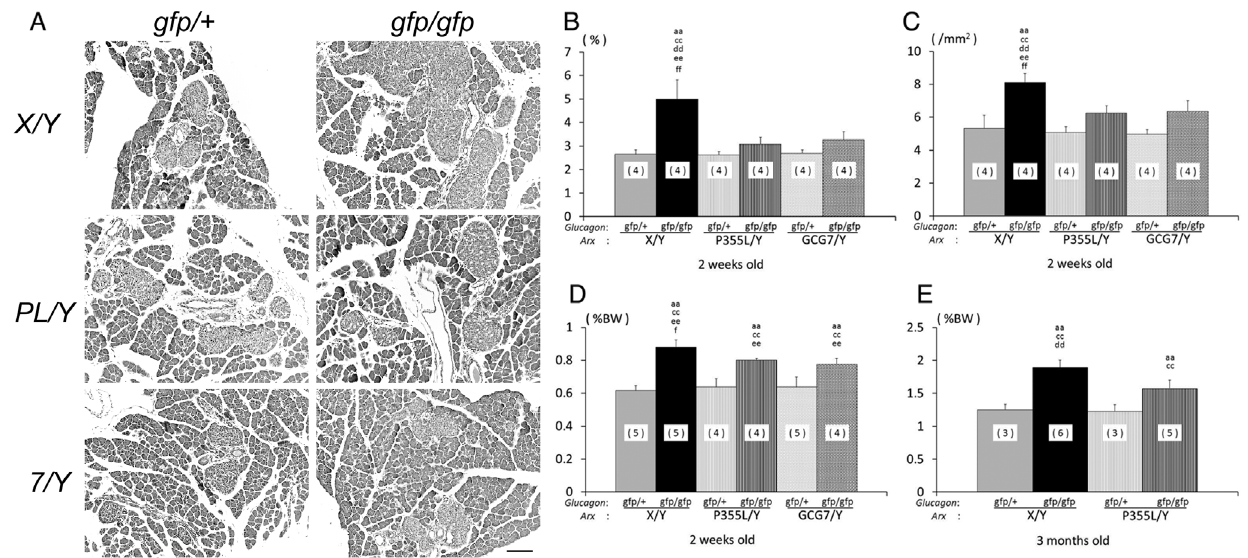
Figure 4. Morphometric analyses of the pancreas in Gcg/Arx double mutant mice. (A) Representative HE-stained images of pancreas sections. (B) Relative dimension/area of islets per pancreas in 2-week-old mice. (C) Relative number of islets per mm 2 in the pancreas of 2-week-old mice. (D) Relative pancreas weight to total body weight in 2-week-old mice. (E) Relative pancreas weight in 3-month-old mice. Number of animals is indicated in parenthesis in each column. ‘aa’ vs Gcg gfp/ + Arx + /Y , P , 0.01; ‘cc’ vs Gcg gfp/ + Arx PL/Y , P , 0.01; ‘dd’ vs Gcg gfp/gfp Arx PL/Y , P , 0.01; ‘ee’ vs Gcg gfp/ + Arx 7/Y , P , 0.01; ‘ff’ vs Gcg gfp/gfp Arx 7/Y , P , 0.01.